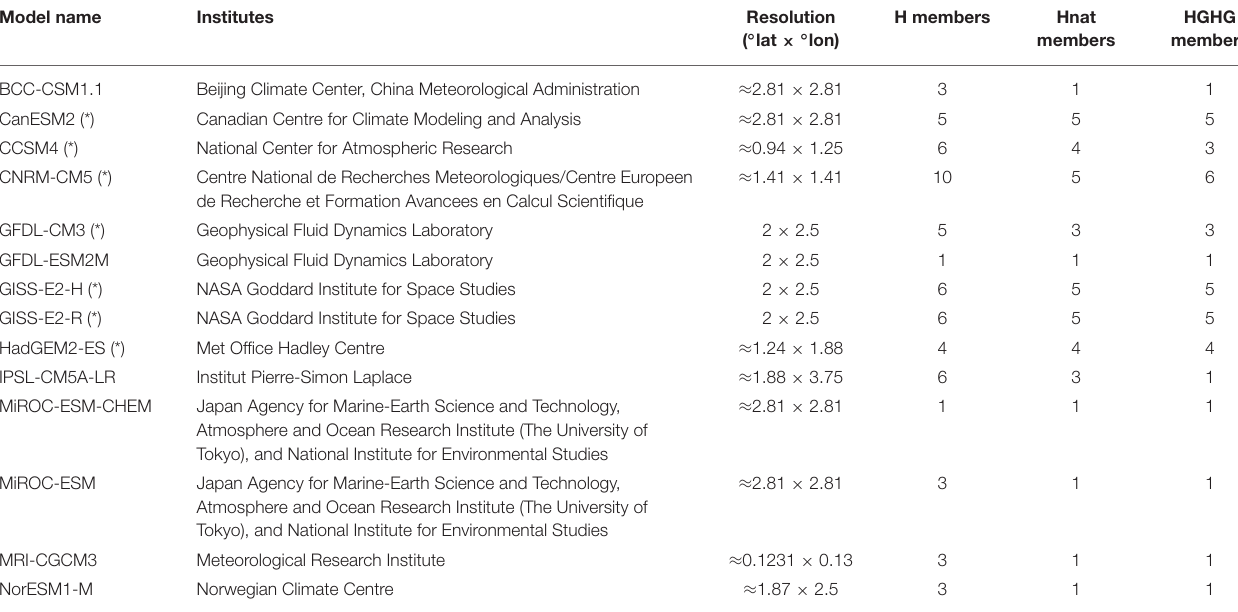
TABLE 2 | CMIP5 Models and experiments used in the study.